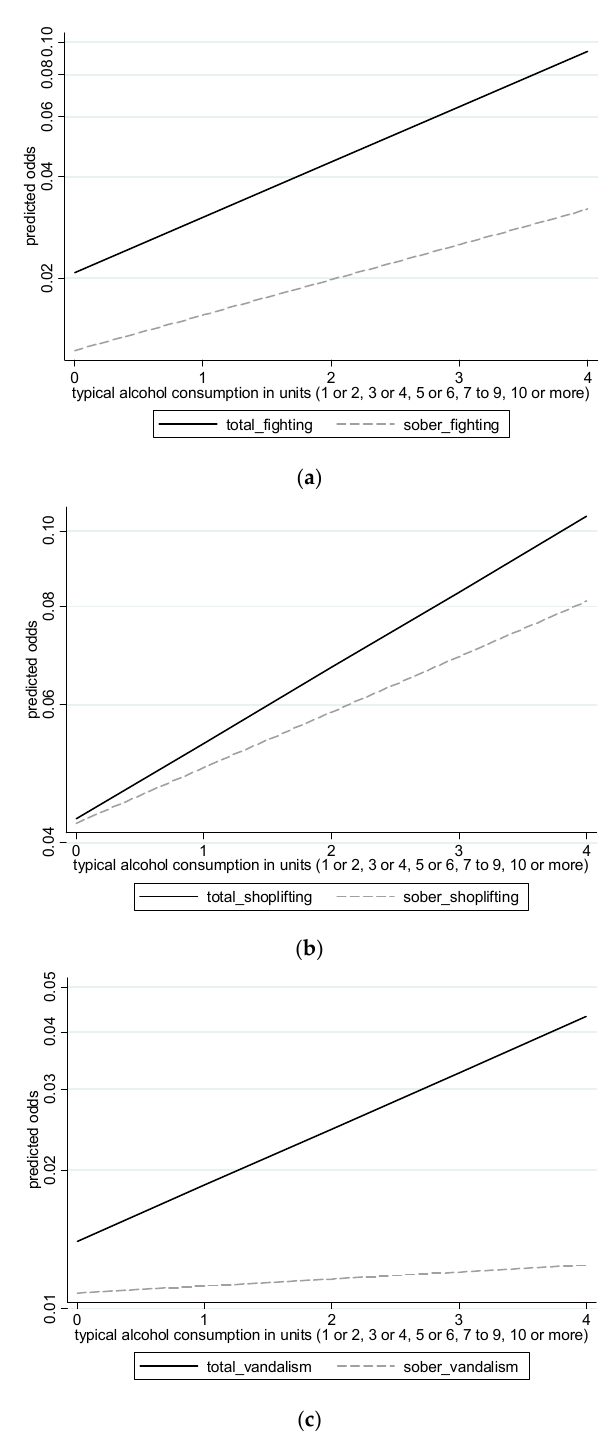
Figure 1. ( a ) Predicted odds of total fighting (solid black line) and sober fighting (dashed grey line) according to units of alcohol consumed in a typical drinking session; ( b ) Predicted odds of total shoplifting (solid black line) and sober shoplifting (dashed grey line) according to units of alcohol consumed in a typical drinking session; ( c ) Predicted odds of total vandalism (solid black line) and sober vandalism (dashed grey line) according to units of alcohol consumed in a typical drinking session. In each figure, the solid black line represents the total association (both non-causal and causal), and the dashed grey line represents the non-causal association; a black line steeper than the grey line indicates a causal effect of alcohol on